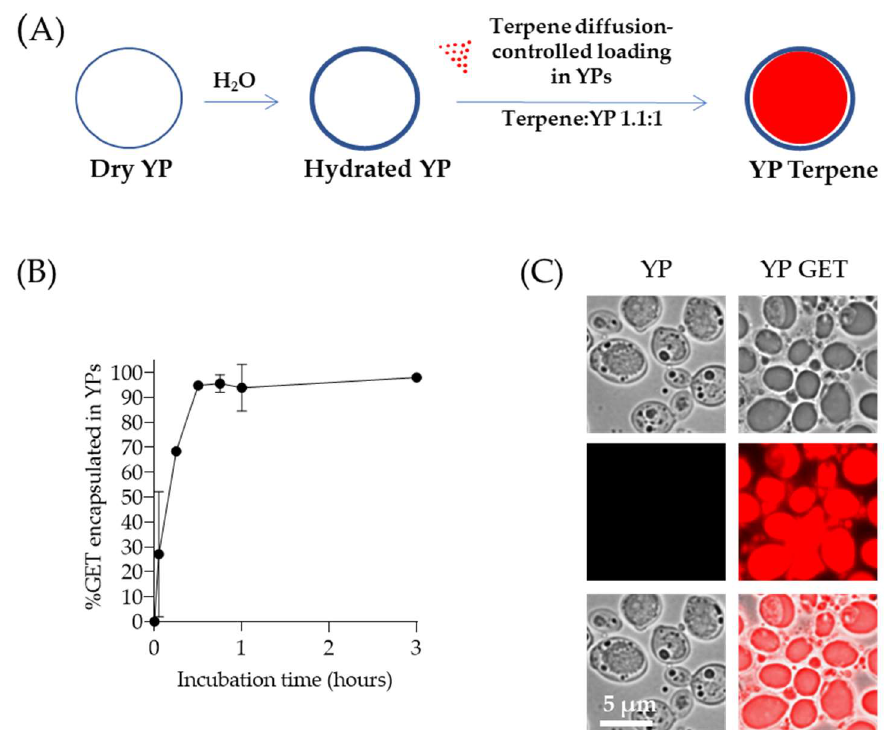
Figure 1. ( A ) Schematics of diffusion-controlled terpene loading in YPs, ( B ) kinetics of 2:1:2 GET loading in YPs quantified by HPLC of samples prepared at a GET:YP ratio of 1.1:1 in a homogenized YP suspension (final concentration of 150 g YP/L, 16.5% GET), and ( C ) microscopy images of Nile red-stained YP control (t = 0) and YPs loaded with GET after 1-hour incubation. Brightfield images show a droplet inside YP GET, and Nile red staining of hydrophobic terpene confirms this droplet corresponds to a terpene droplet loaded in YPs. Figures adapted from Reference [40] and reproduced with permission from MDPI .